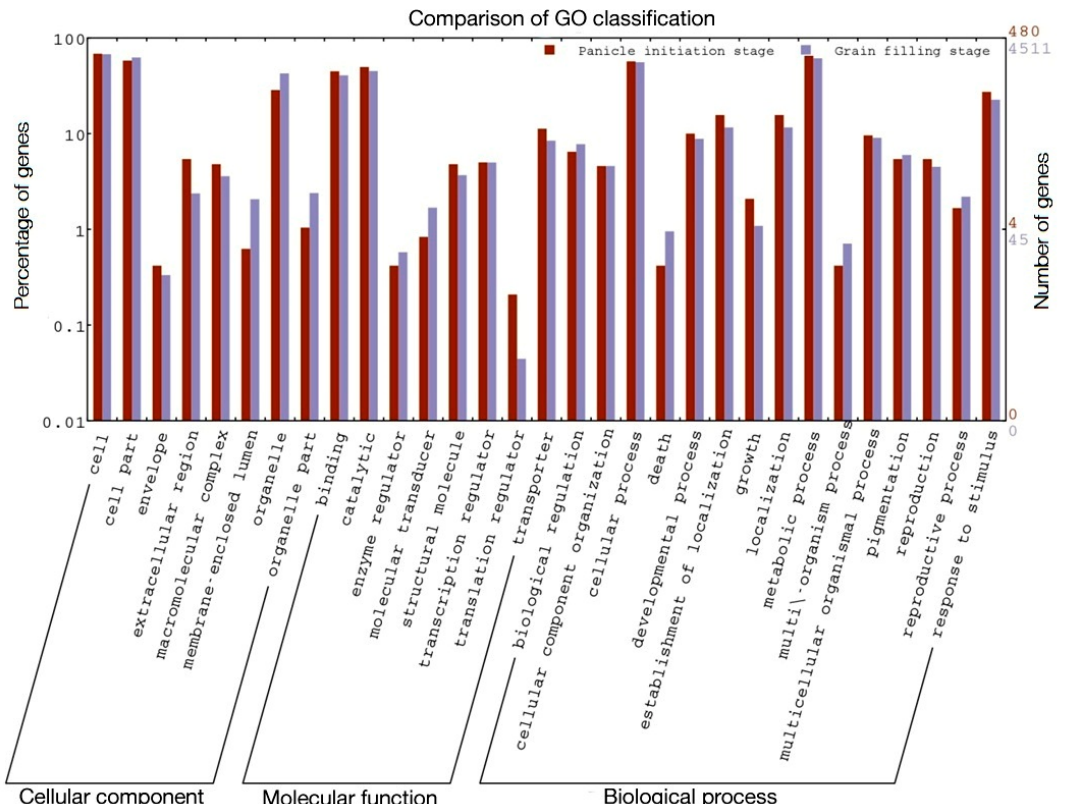
Figure 4. KEGG pathway incident of panicle initiation and grain filling stage in Rajalaxmi hybrid.